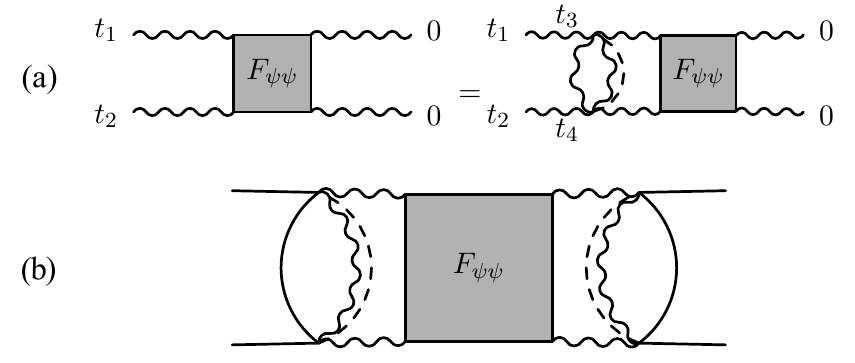
Figure 4 . (a). Diagrammatic representation of the self consistency equation (2.21). (b). At order O ( 1 ), the OTOC F (cid:31)(cid:31) contains F as an inner N 2